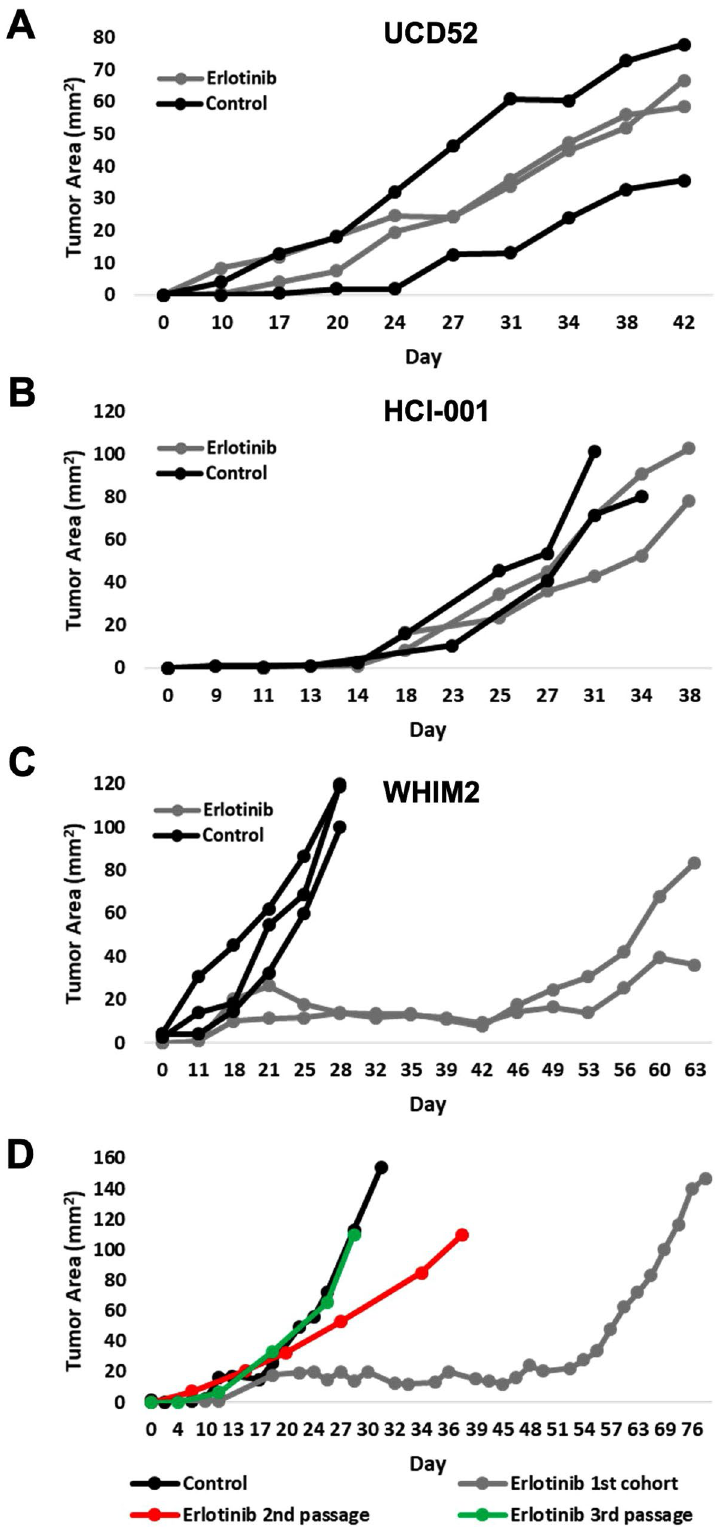
Figure 1. Development of acquired erlotinib-resistance in an erlotinib-sensitive PDX. ( A ) UCD52; ( B ) HCI-001; and ( C ) WHIM2 PDXs were treated with erlotinib-incorporated mouse chow ad libitum once tumors were palpable; ( D ) WHIM2 tumors were treated with erlotinib chow until resistance arose (1st passage) ( n = 2). The first cohort of resistant tumors were passaged into a second cohort of mice (2nd passage) ( n = 4), and mice were treated with erlotinib chow once tumors were palpable. The second cohort’s tumors were then passaged into a third cohort of mice and treated with erlotinib chow. The third cohort’s tumors were considered erlotinib-resistant ( n =